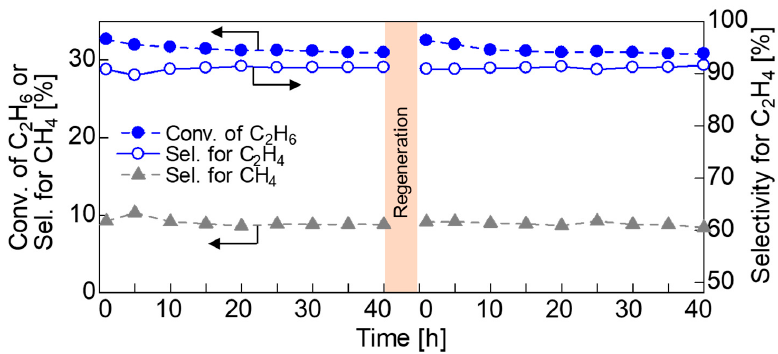
Figure 4. Time course of ethane dehydrogenation using In-CHA(Al-rich) under a high concentration of ethane at 993 K.